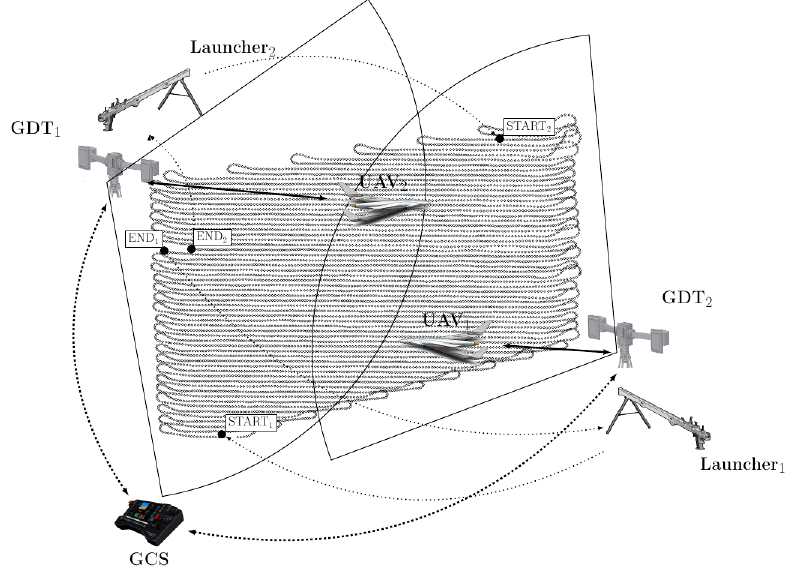
Figure 4. Model for trajectory generation in two-UAV applications.